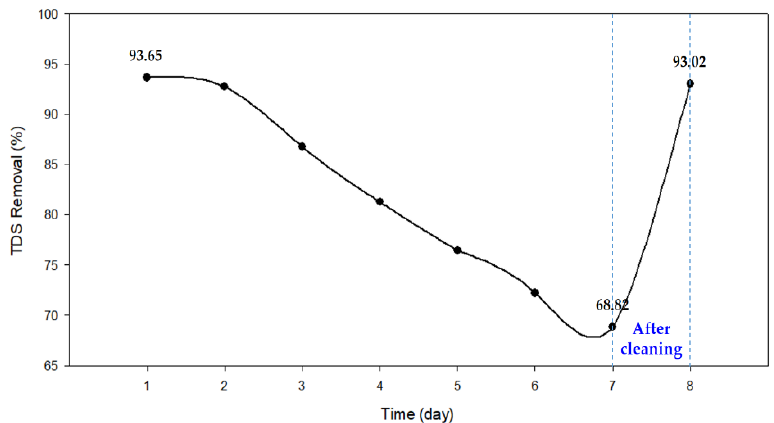
Figure 15. The variation of TDS removal rate over 7 days of 24 h per day operation and after cleaning at 8 days; The average TDS removal rate was 93.65% on day 1 and gradually fell to 68.82% on day 7. After cleaning processes, the TDS removal rate recovered to the initial level of 93.02%.